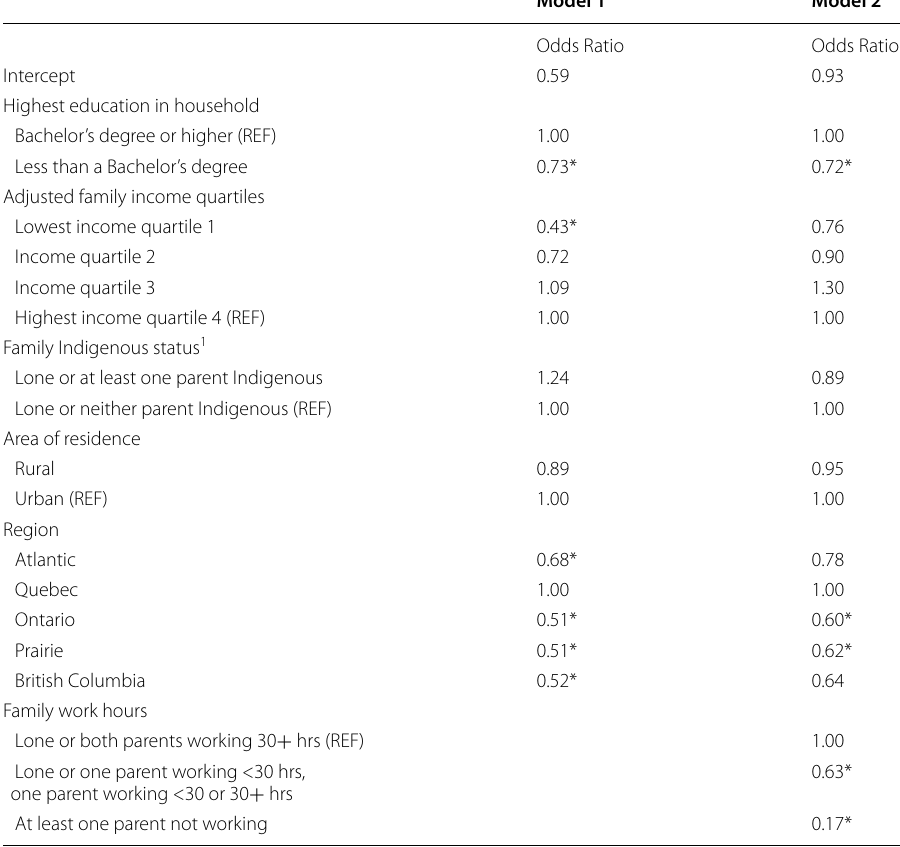
Table 4 Logistic Regression Predicting Claimants of the Child Care Expense Deduction among Families with a Child less than 6 -